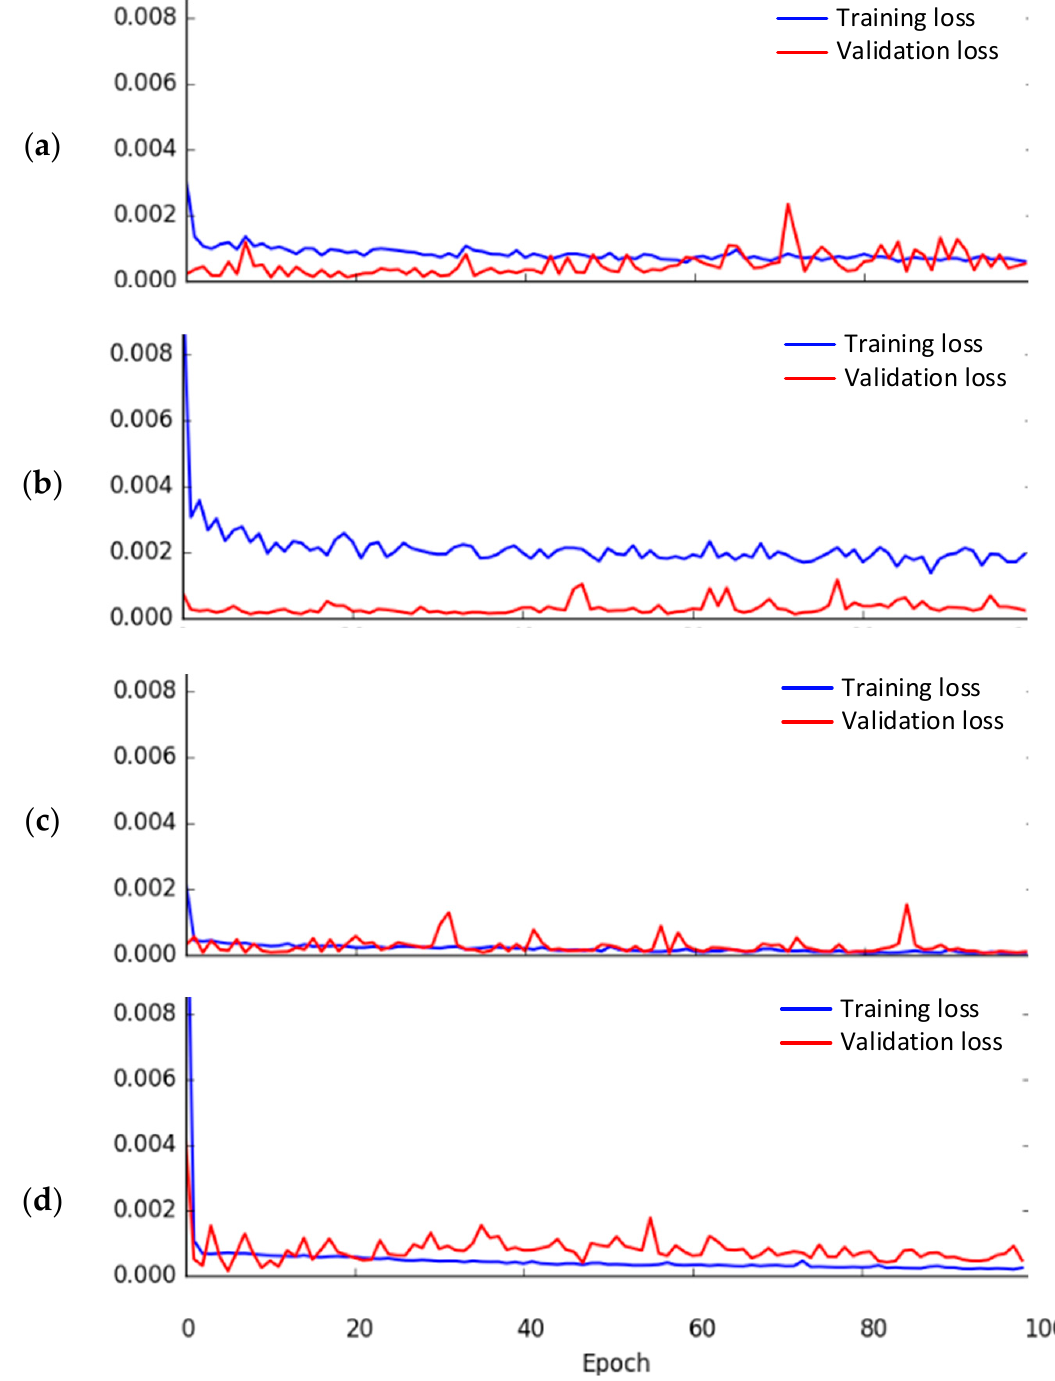
Figure 10. The model loss of RSRP after 4 s of prediction: ( a ) MLP, ( b ) CNN, ( c ) RNN, ( d ) LSTM.